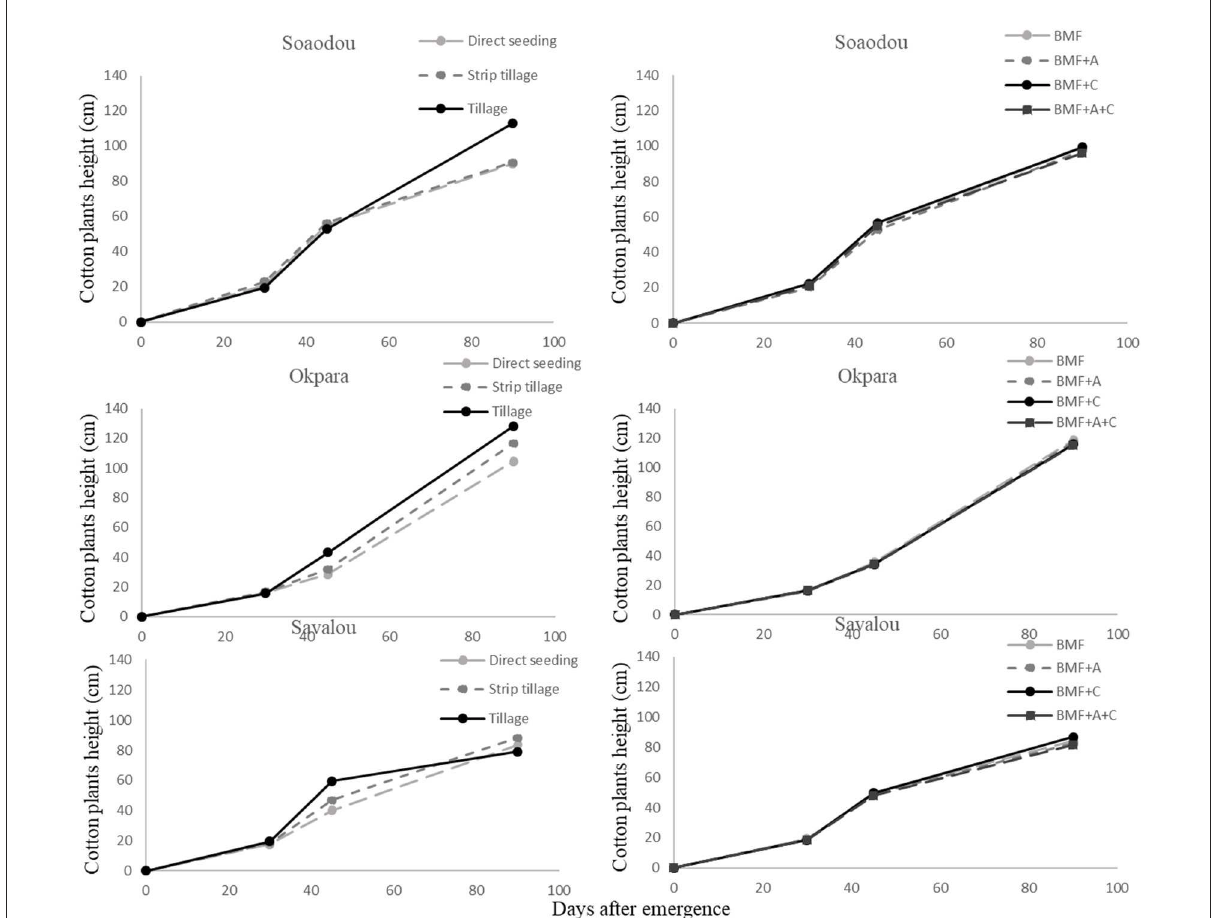
FIGURE3 Cotton plant height at 30, 45 and 90 days after emergence. A: 200 kg ha − 1 of calcium phosphate amendment (22P2O5-43CaO-4S). C: 400kg ha − 1 of compost. BMF, Basal mineral fertilizers 200kg ha − 1 of N14P18K18S6B1 + 50kg ha − 1 of urea